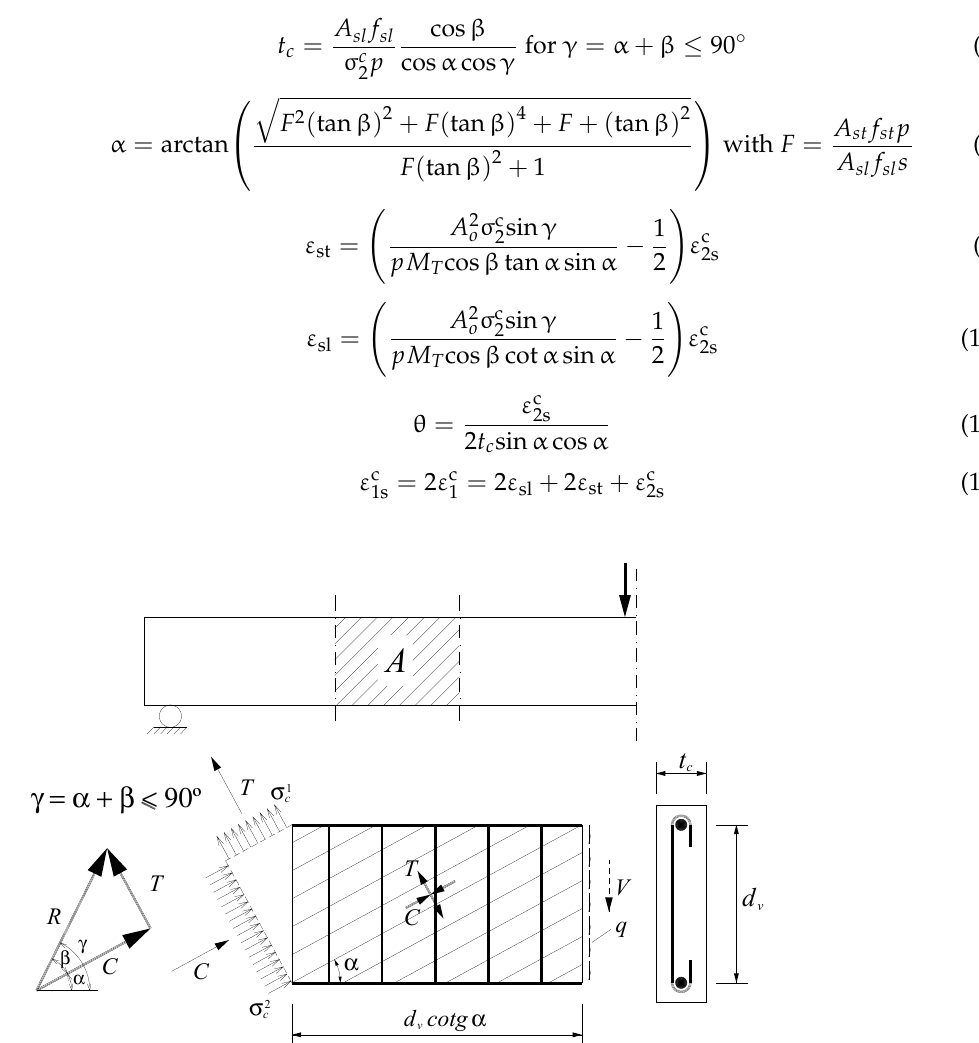
Figure 1. Reinforced concrete (RC) thin beam element [18]. An equivalent cracked RC hollow beam under a torque 𝑀 2, is modeled as the union of four thin beam elements as in Figure 1. Each thin beam con- stitutes a wall of the RC hollow beam. As a result of this union, the torque 𝑀 circulatory shear flow 𝑞 and the beam can be modeled with a smeared spatial truss anal- ogy. The center line of the circulatory shear flow 𝑞 coincides with the center line of the walls. The behavior of the RC hollow beam is governed by equilibrium equations, Equa- tions (6) to (8), and compatibility equations, Equations (9) to (12). If γ = α + β > 90° , Equation (7) must be multiplied by ( − 1). The previous equations account for the strain gradient along the walls’ thickness due to the bidirectional opposite curvatures induced by bending (Figure 3).